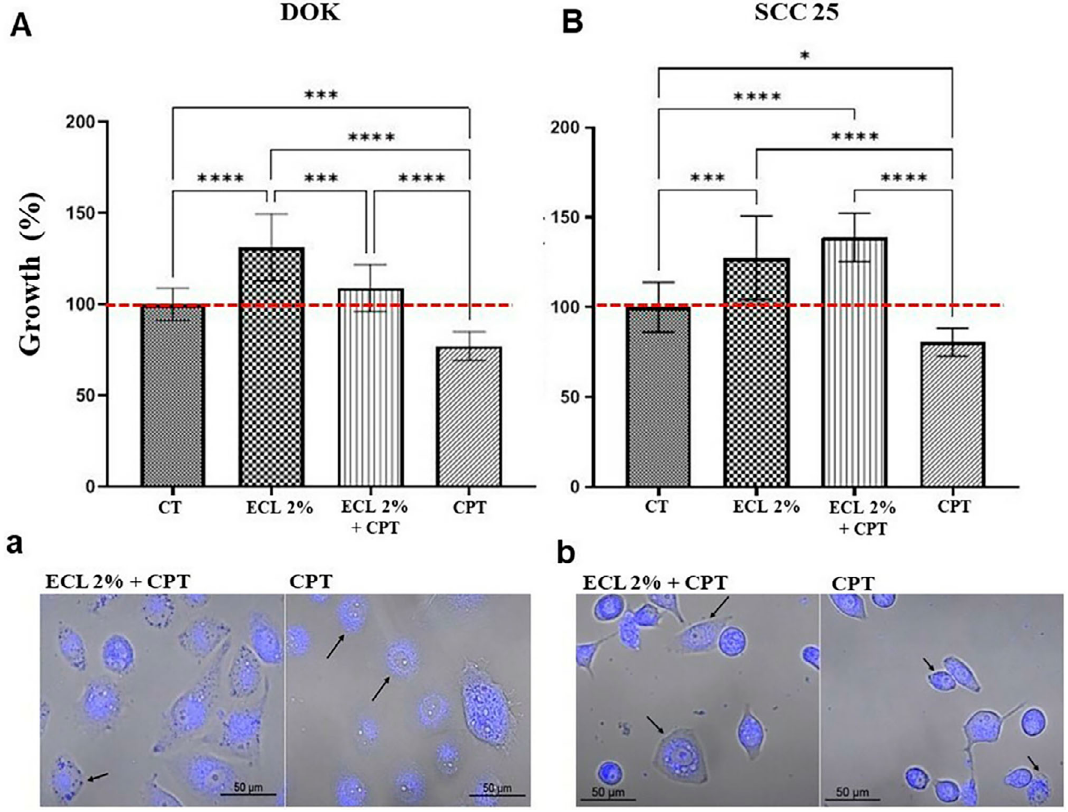
Figure 5- AlamarBlue and CPT uptake of DOK and SCC 25 cells cultured with ECL of C. albicans biofilm. DOK and SCC 25 cells were cultured with ECL of C. albicans for 72 hours. Then, the cells were challenged with the topoisomerase I inhibitor CPT for another four hours, followed by the alamarBlueTM assay (n=12). DOK cells (A) showed statistical differences between all groups. SCC 25 cells (B) showed statistical differences between all groups, except for the cells exposed to ECL 2% v/v and ECL 2% v/v + CPT (*p<0.05; ***p<0.001; ****p<0.0001). CPT uptake with brightfield and 405 nm fluorescence emission (arrows) for (a) DOK (n = 6) and (b) SCC 25 (n=6)